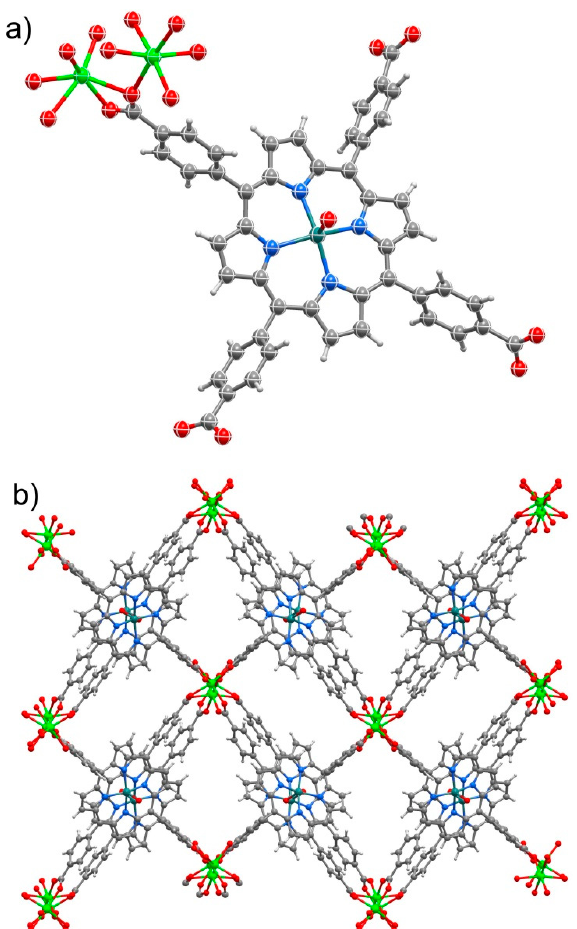
Figure 9. Schematic representation of the ( a ) asymmetric unit and ( b ) the crystal packing of MMPF viewed along [1,0,0] direction. (Colour scheme: bright green = Fe, dark yellow = Mn, gray = H, dark gray = C, light blue = N, red = O).